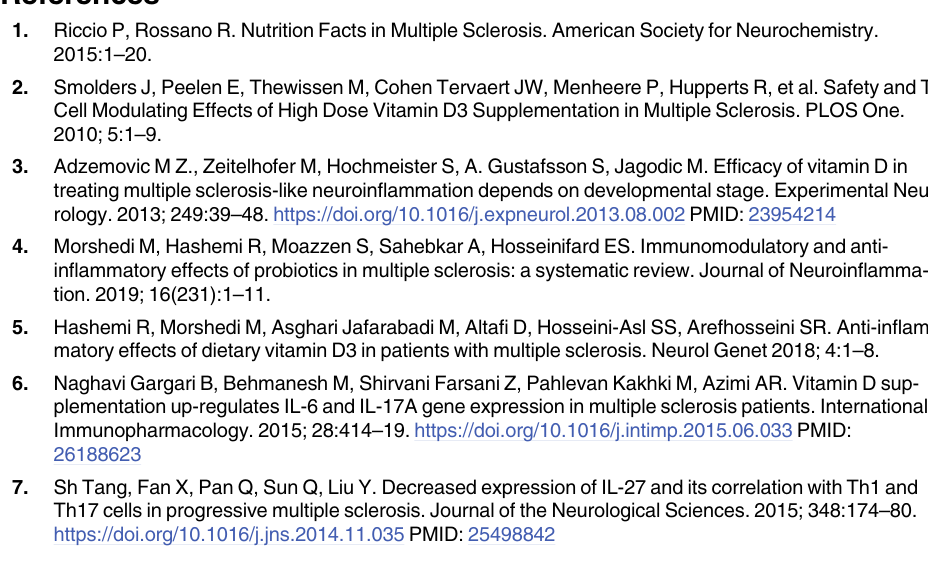
S1 Table. Interleukin Δ CT and vitamin D3 serum levels (ng/ml) at baseline and after eight weeks of